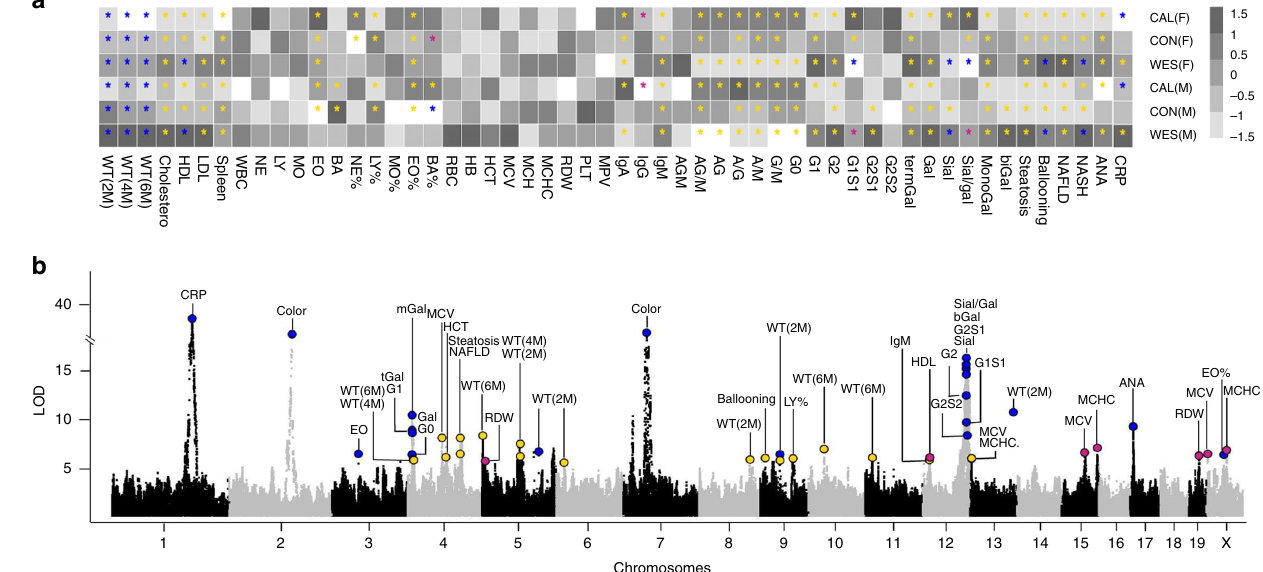
NATURE COMMUNICATIONS| (2019) 10:4097